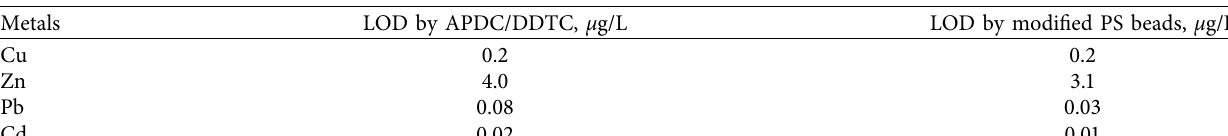
Figure 6: The relationship of absorbance and concentration of Zn (a), Pb (b), Cu (c), Cd (d), and fitting curve and correlation coefficient. Table 4: LOD of Cu, Zn, Pb, and Cd.